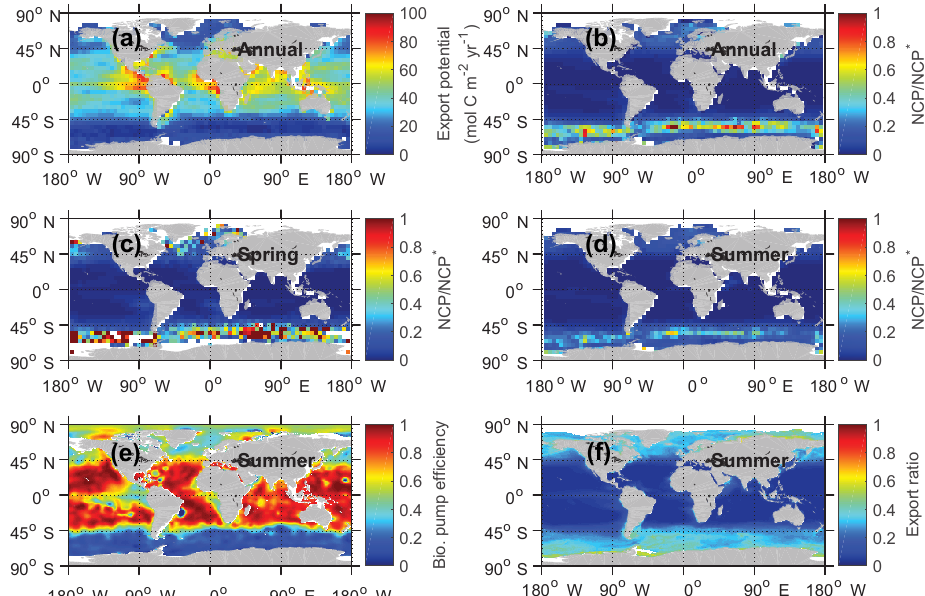
Figure 5. (a) Modeled upper bound on carbon export derived from Eq. (19), (b–d) ratios of satellite export production estimates to the upper bound on carbon export, (e) biological pump efficiency calculated as the difference in nutrient concentrations between surface and depth normalized to nutrient concentrations at depth (Sarmiento and Gruber, 2006; nitrate concentration from the World Ocean Atlas at https://www.nodc.noaa.gov/OC5/woa13/), and (f) export ratio derived from Dunne et al. (2005). “Annual” represents the annually integrated value. Spring and summer represent the average value in spring and summer, respectively. In the Northern Hemisphere, the spring and summer seasons are defined as March–May and June–August, respectively. In the Southern Hemisphere, the spring and summer seasons